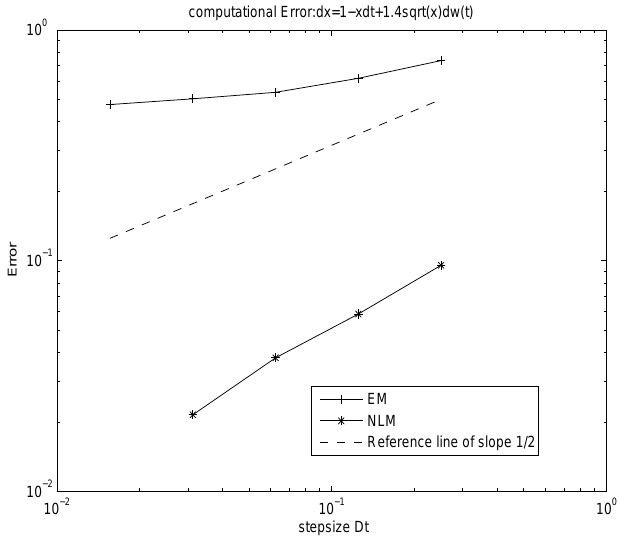
√ xdW . The time interval: [ 0,1 ] , the number